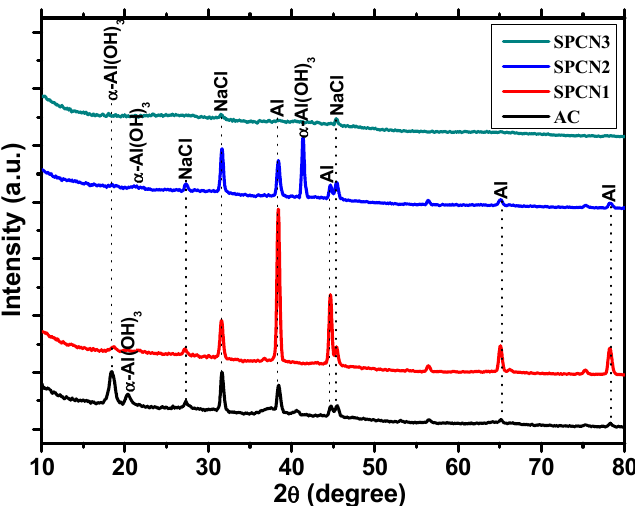
Figure 11. XRD of corrosion products formed onto the coating surface after 89 days of exposure in 3.5 wt.% NaCl solution .